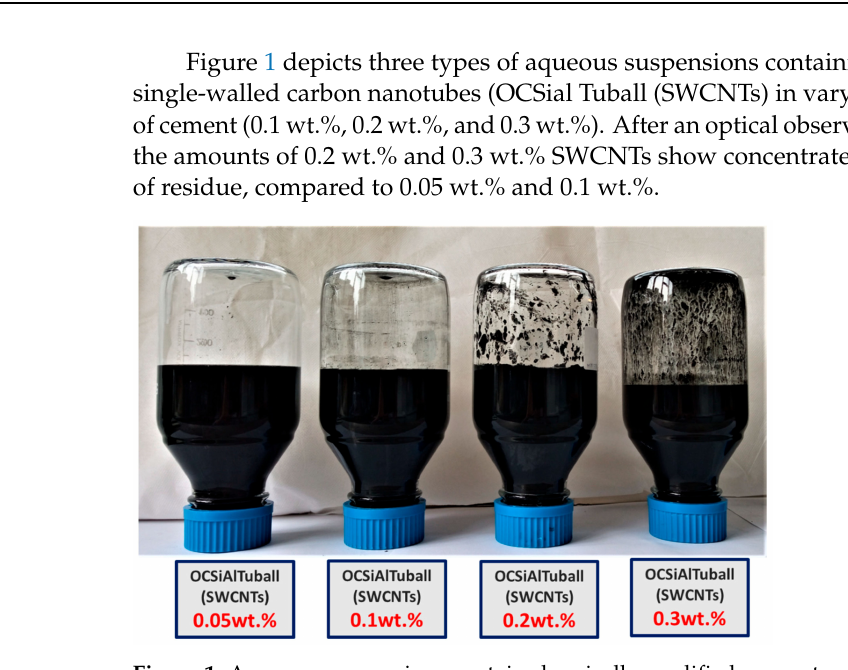
Figure 1. Aqueous suspensions contain chemically modified amounts per weight of cement single- walled carbon nanotubes